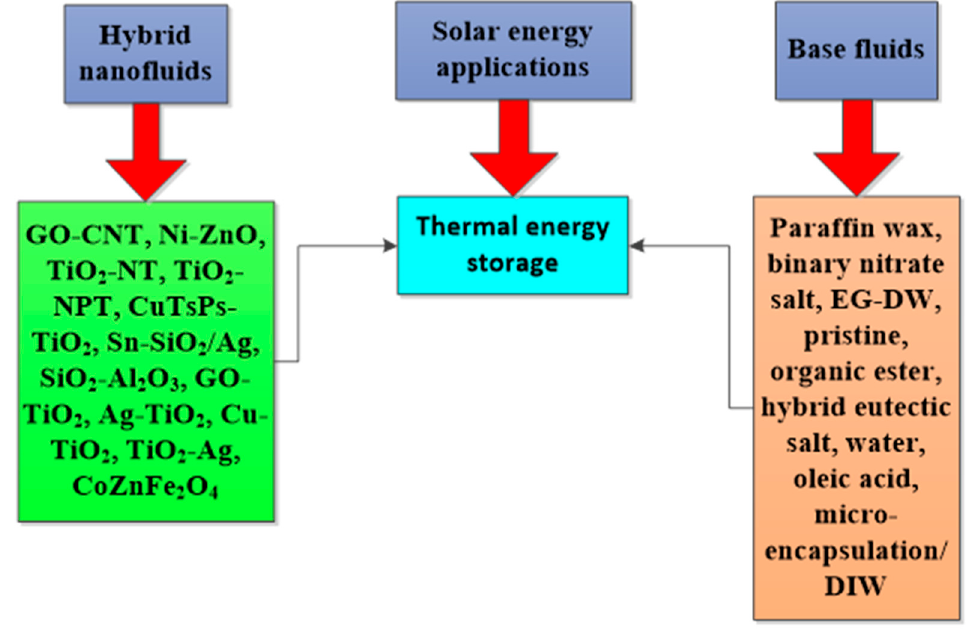
Figure 16. Hybrid nano ‐ materials deployed as thermal energy storage materials.